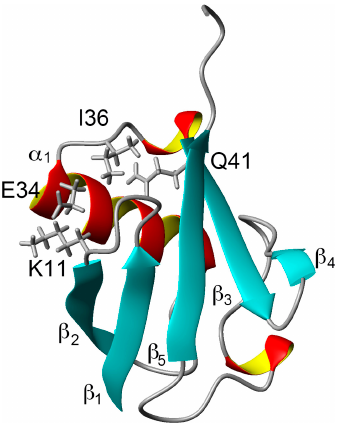
Figure 1. Three-dimensional structure of ubiquitin (PDB ID: 1D3Z). Sidechains of K11, E34, I36, and Q41 are shown as stick models. α -helices are marked by red and yellow, β -sheets are marked by cyan.